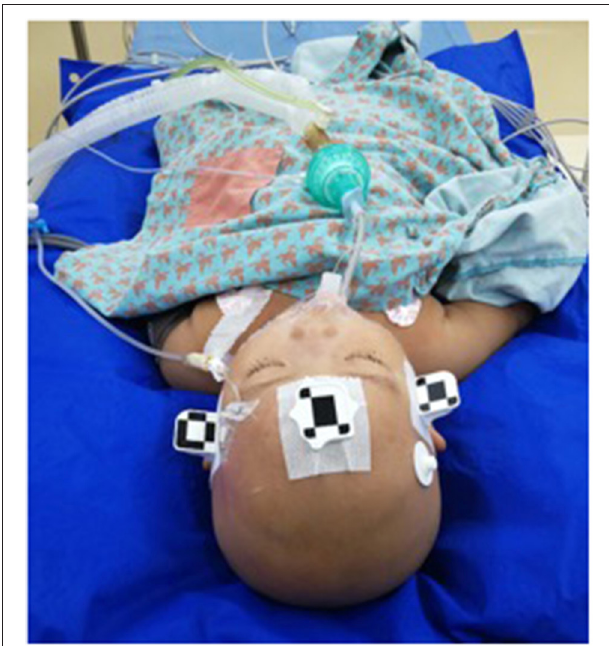
FIGURE 1 | The dedicated videometric-tracked marker was fastened to the scalp.